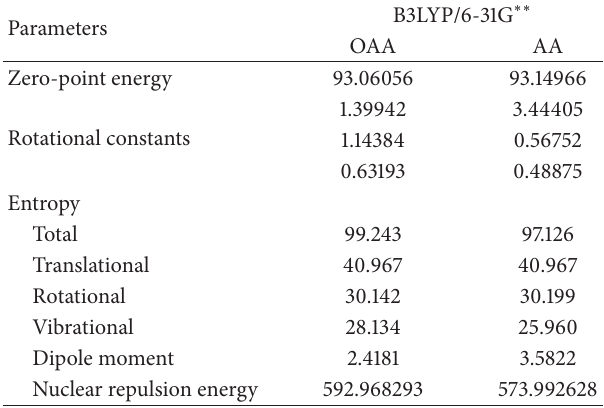
Figure 8: Plot of the calculated versus the experimental 13 C NMR and 1 H NMR chemical shifts (ppm) for O-Anisic acid. constants with the proper accuracy, and the GIAO method is Table 14: Theoretically computed energies (a.u.), zero-point vibra- tional energies (kcal mol − 1 ), rotational constants (GHz), entropies (cal mol − 1 K − 1 ), nuclear repulsion energy (Hartrees), and dipole magnetic shielding tensors. moment (Debye) for OAA and